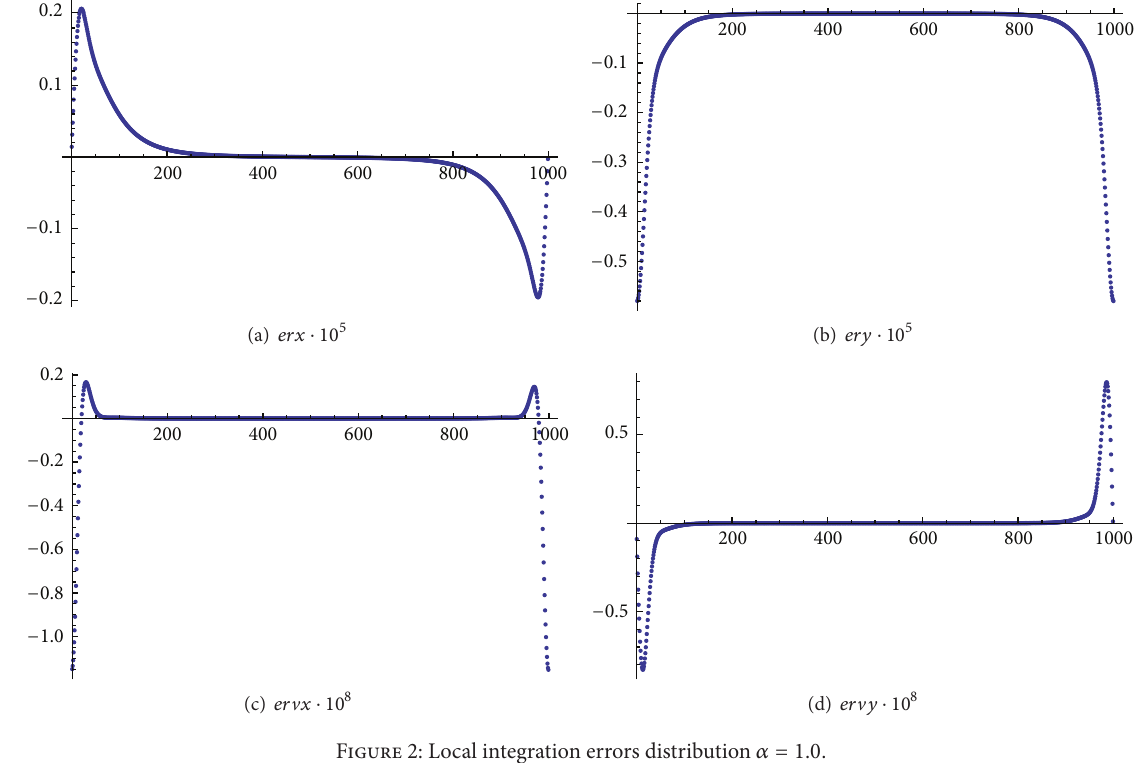
Figure 2: Local integration errors distribution 𝛼 = 1.0 .